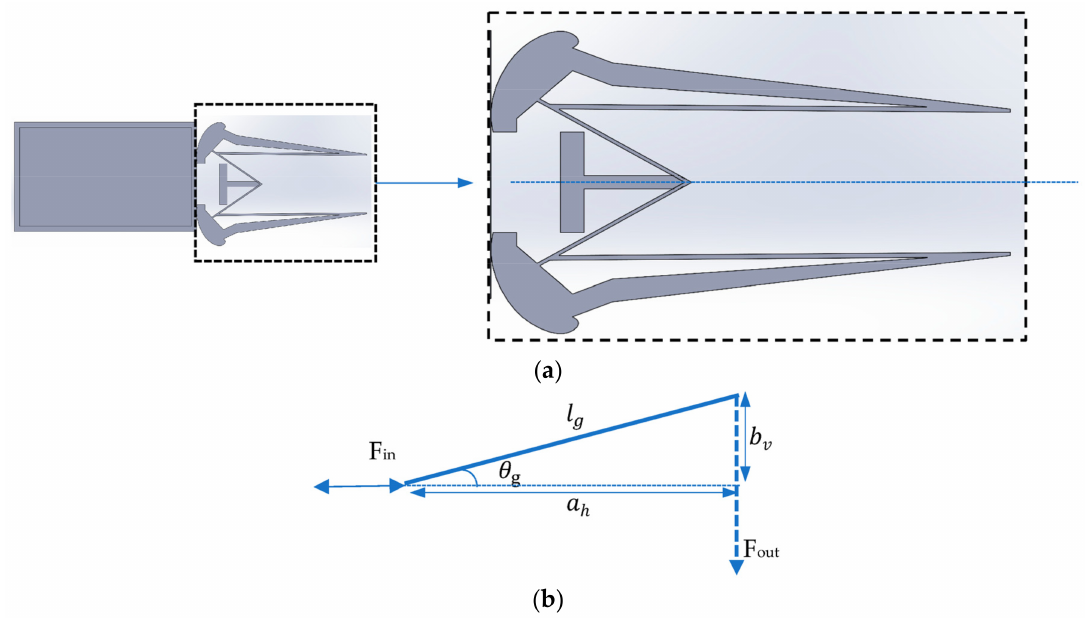
Figure 2. Gripping system: ( a ) symmetrical complaint gripping system, ( b ) upper section of the symmetrical angular